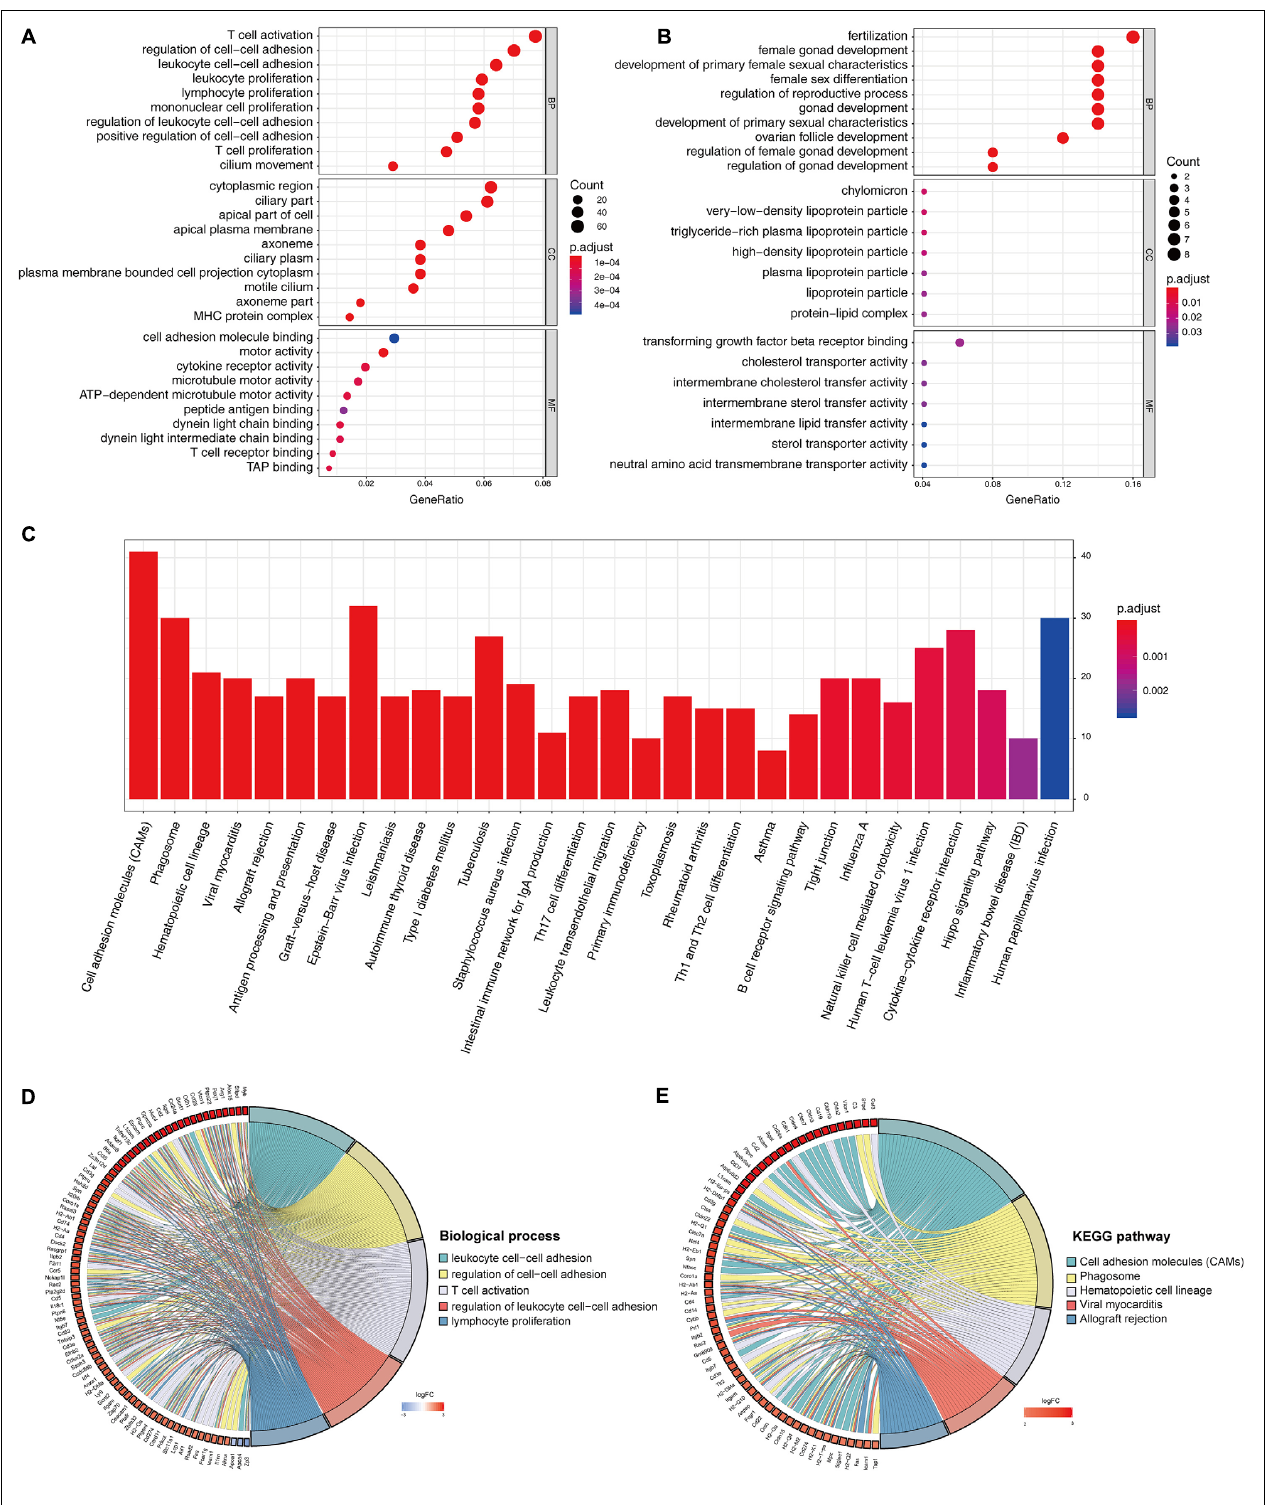
FIGURE 2 | Functional enrichment analysis of DEG. GO enrichment analysis of upregulated DEG in ovarian aging (A) . GO enrichment analysis of downregulated DEG in ovarian aging. GO analysis divided DEG into three functional groups: biological process (BP), cellular component (CC), and molecular function (MF) (B) . KEGG pathway enrichment analysis of DEG (C) . Distribution of DEG in ovarian aging in the significant GO terms of biological process (D) . Chord plot of the relationship between DEG and KEGG pathways (E) .